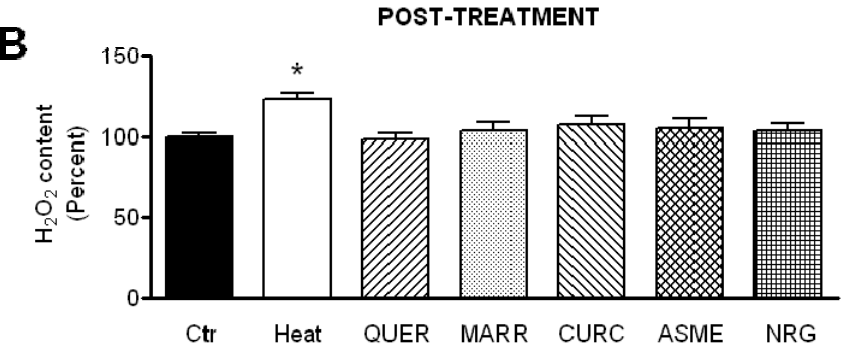
Figure 6. Effect of pre- and post-treatment with quercetin (QUER), marrubiin (MARR), curcumin (CURC), ASME and naringenin (NRG) on the H 2 O 2 content in heat-stressed HeLa cells. ( A ) Pre-treatment: hydrogen peroxide (H 2 O 2 ) was measured using the CM-H2DCFDA reagent (see Materials and Methods) in normal (Ctr) and heat-stressed condition in the presence or in the absence (Heat) of different compounds (20 µ M final concentration); ( B ) Post-treatment: H 2 O 2 was measured in HeLa cells in the following conditions: normal (Ctr), heat-stressed (Heat) and heat-stressed cells post-treated with the antioxidants compounds (20 µ M final concentration). Bars represent the H 2 O 2 content in HeLa cells expressed as percent. Values are means ± SEM of 4 different experiments. * p < 0.05 vs. Ctr, QUER, MARR, CURC, ASME, NRG; ◦ p < 0.05 vs. Ctr, Heat, MARR, CURC, ASME, NRG (ANOVA followed by Newman–Keuls’ Q